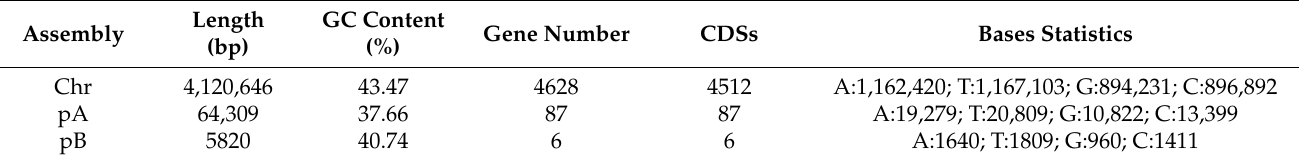
Table 2. Whole genome assembly of B. subtilis A-5.